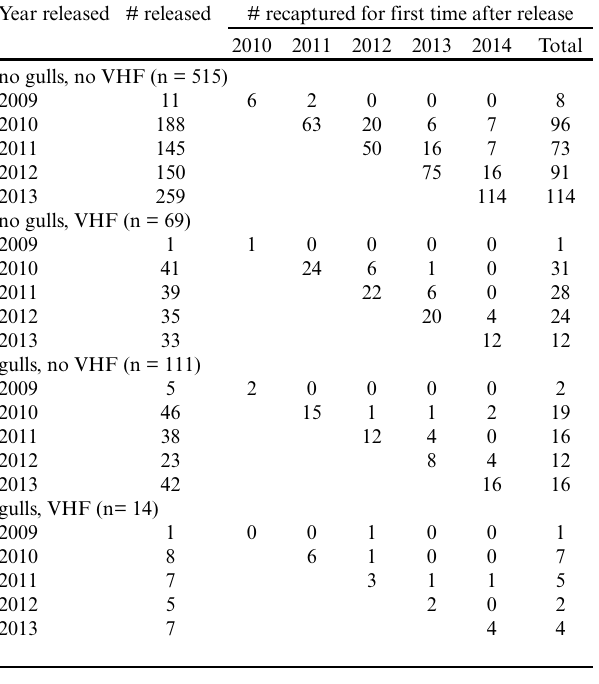
Table 1 . Reduced m-array showing when and how many adult Leachapo’s Storm-petrels ( Oceanodroma leucorhoa ) were recaptured for the first time after initial release at Bon Portage Island, Nova Scotia, Canada, 2009 to 2014. Note that “# released” at a particular occasion (Year released) includes storm- petrels newly banded and those that were previously banded and recaptured at that occasion. Storm-petrels were separated into those nesting in plots with (gulls, 10 plots) and without (gulls, 2 plots) Herring Gulls ( Larus argentatus ) and those with (very high frequency [VHF]) and without (no VHF) VHF tags. Sample size of storm-petrels at initial capture is shown in parentheses. Numbers of storm-petrels from each group were pooled for the initial analysis.